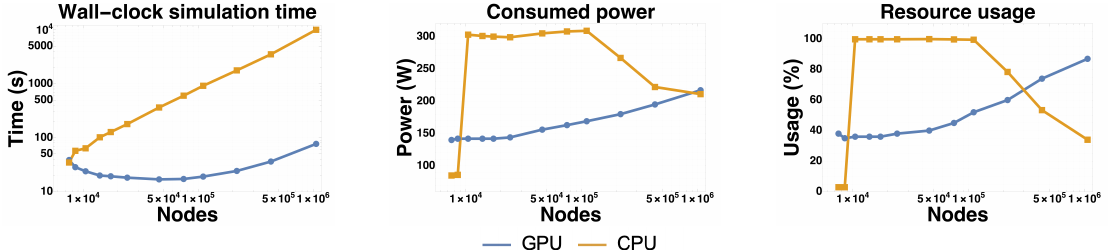
Figure 4. Comparison of performances of the GPU and the CPU for 5000 steps. The plots compare resolution on the GPU and on the CPU for 3 metrics of interests: wall-clock simulation time, average power consumption and resource